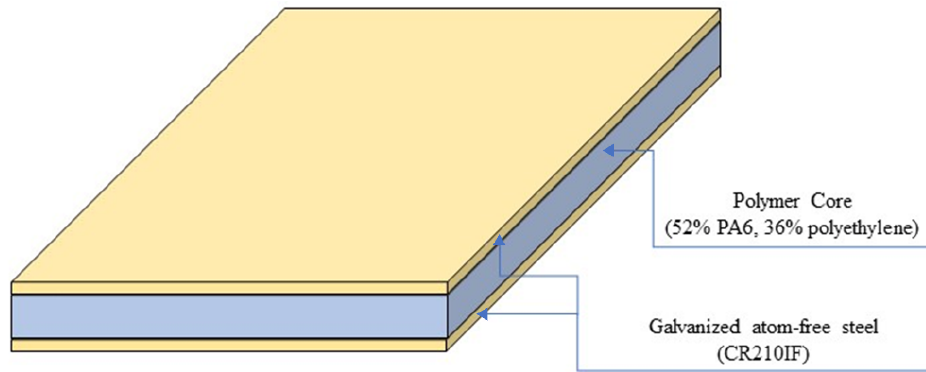
Figure 2. Flow chart of the experimental procedures.